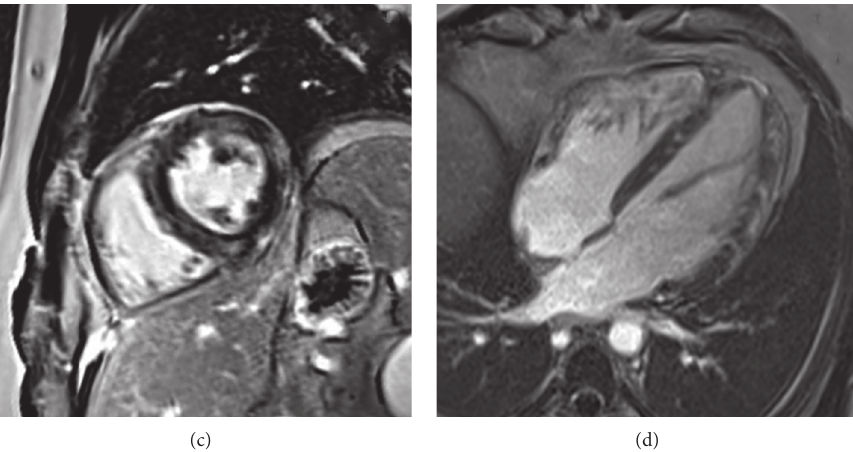
Figure 3: Cardiac MRI showed features consistent with myocarditis satisfying the updated Lake Louise criteria [4], visualized in these images. (a) Mid-short-axis native T1 mapping demonstrated elevated native myocardial T1 at 1173ms (local lab normal reference: 950–1050ms). (b) Mid-short-axis T2 mapping demonstrated elevated myocardial T2 at 58 ms (normal reference: 40–50 ms). (c) Mid-short- axis phase-sensitive inversion recovery late gadolinium enhancement image showed multiple areas of subepicardial enhancement in the lateral wall, as well as midmyocardial enhancement in the septum. (d) Four-chamber late gadolinium enhancement image demonstrated midmyocardial enhancement in the septum and subepicardial to midmyocardial enhancement in the lateral wall.